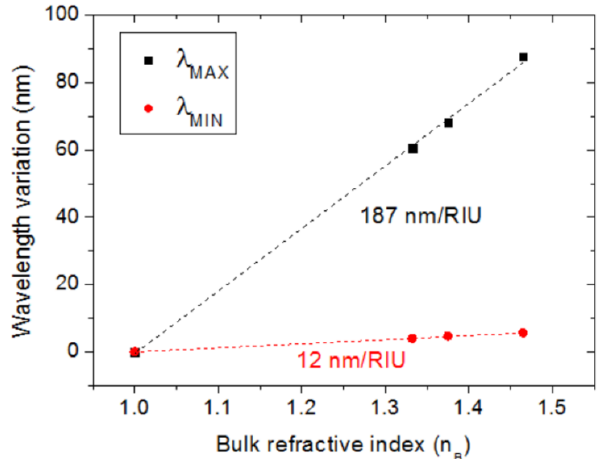
Figure 11. Calculated λ MAX and λ MIN variations as a function of the bulk refractive index (n B